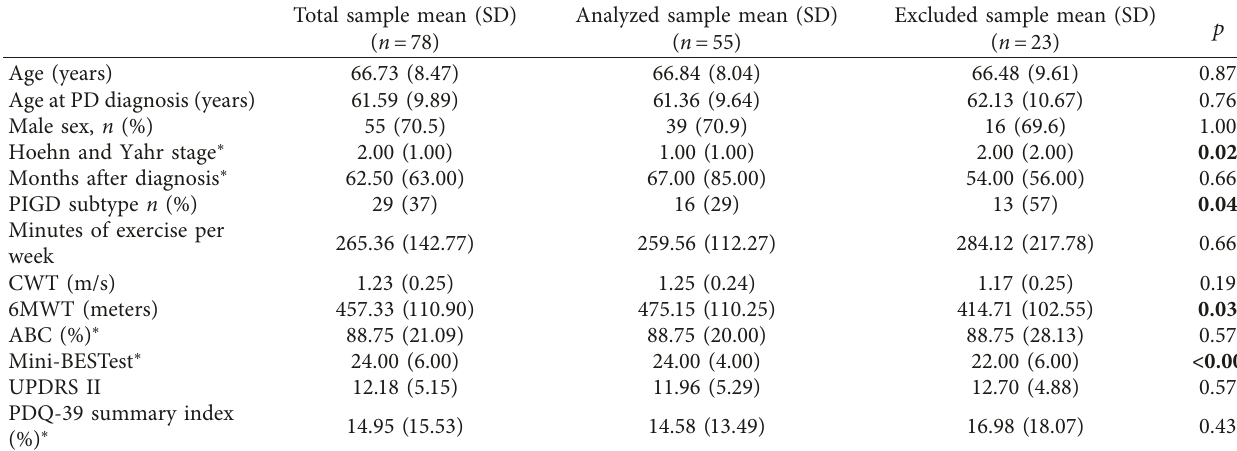
Table 1: Demographic and outcome measures at baseline for the total sample and differences between analyzed and excluded samples across baseline variables.